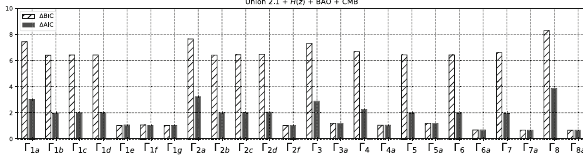
Fig. 3 Coincidence parameter in semilog scale. These interactions have an energy transfer from DE to DM